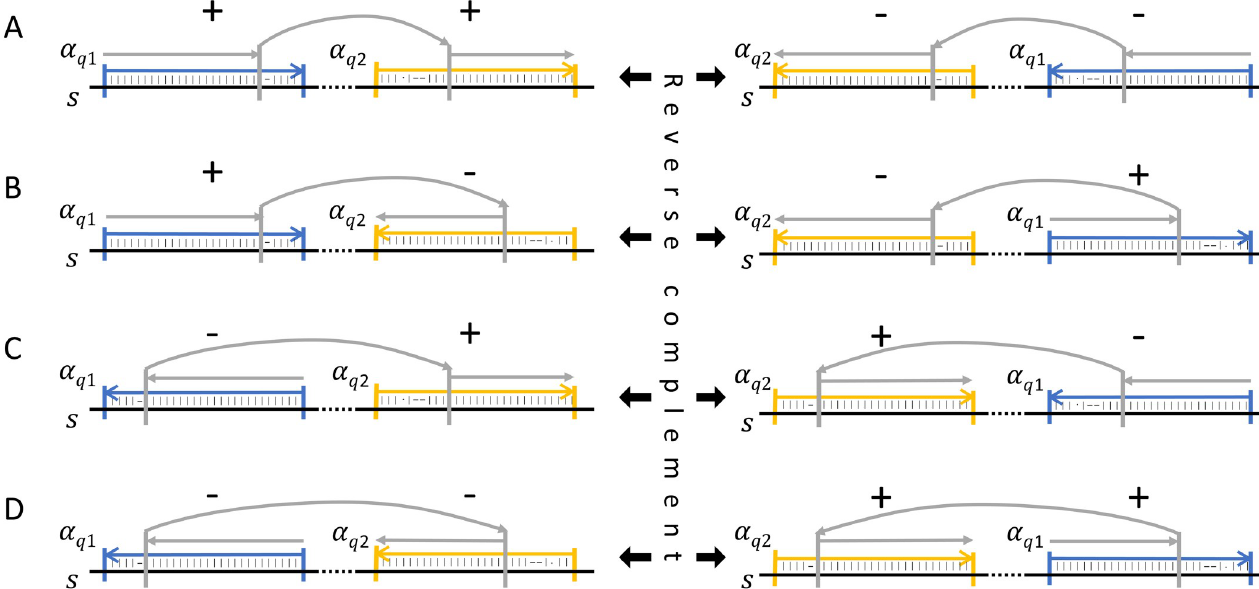
Fig 2. Different orientations of alignment pairs. Each pair consists of two alignments of the same read. The first alignment is marked as the one that involves the left-most part of the read and the second alignment as the one that involves the right-most part of the read. The first alignment is highlighted in blue and the second is highlighted in yellow. If the first alignment has mapped the read to a position in the subject preceding the second alignment, then the pair, as well as the read that covers the junction, is of forward orientation. In the opposite case, the pair, as well as the read that covers the junction, is of reverse complement orientation. When both the first and the second alignment are of forward orientation (A), the pair corresponds to a deletion when the pair itself is of forward orientation. The pair describes a deletion again when both alignment and the pair itself is of reverse orientation (A). Similarly, different combinations of each alignment orientation and their symmetric reverse complement of the pair are described for 3’copy-back (B), 5’ copy-back (C) and insertion of duplicated sequence (D). The grey vertical lines denote the location of the decided breakpoint on the read in case of multiple solutions of the maximum score path.